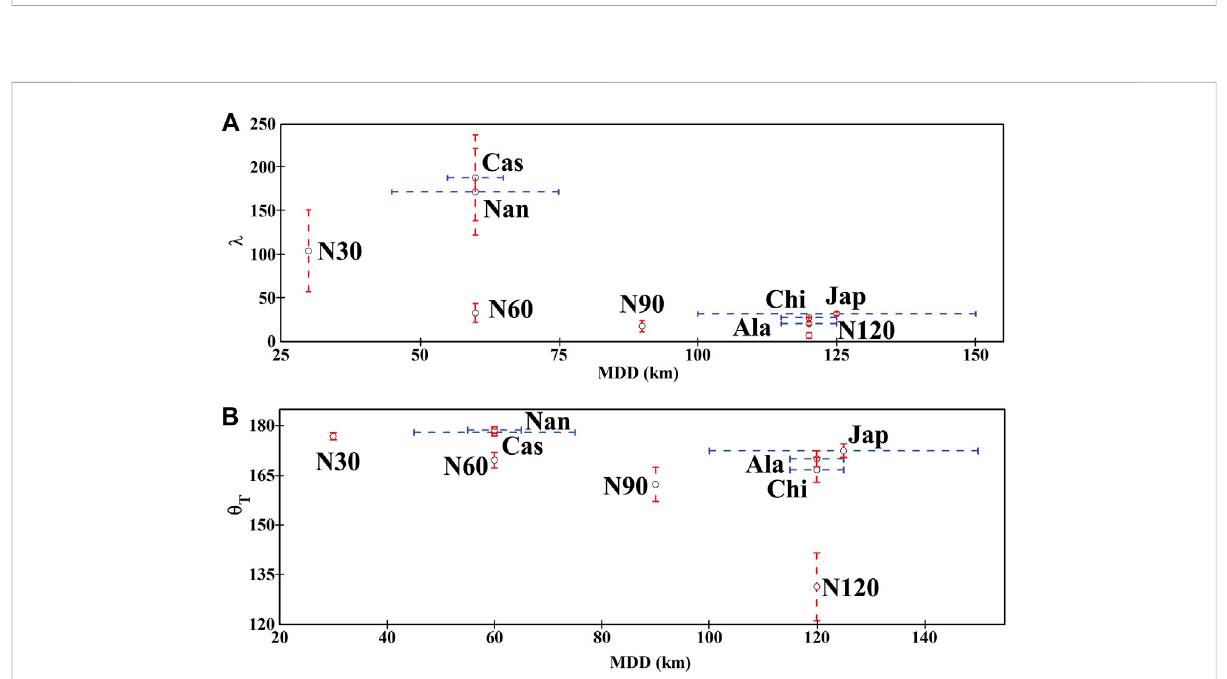
FIGURE 12 Correlations of (A) the shape factor ( λ ) and (B) closing angle ( θ T ) versus MDD plots between selected natural subduction zones and the model experiments. N30, N60, N90, and N120 points represent numerical experiment results with 30, 60, 90, and 120 km MDD values, respectively. Subduction zone abbreviations: Cascadia-Cas; Nankai-Nan; Chile-Chi; Alaska-Ala;